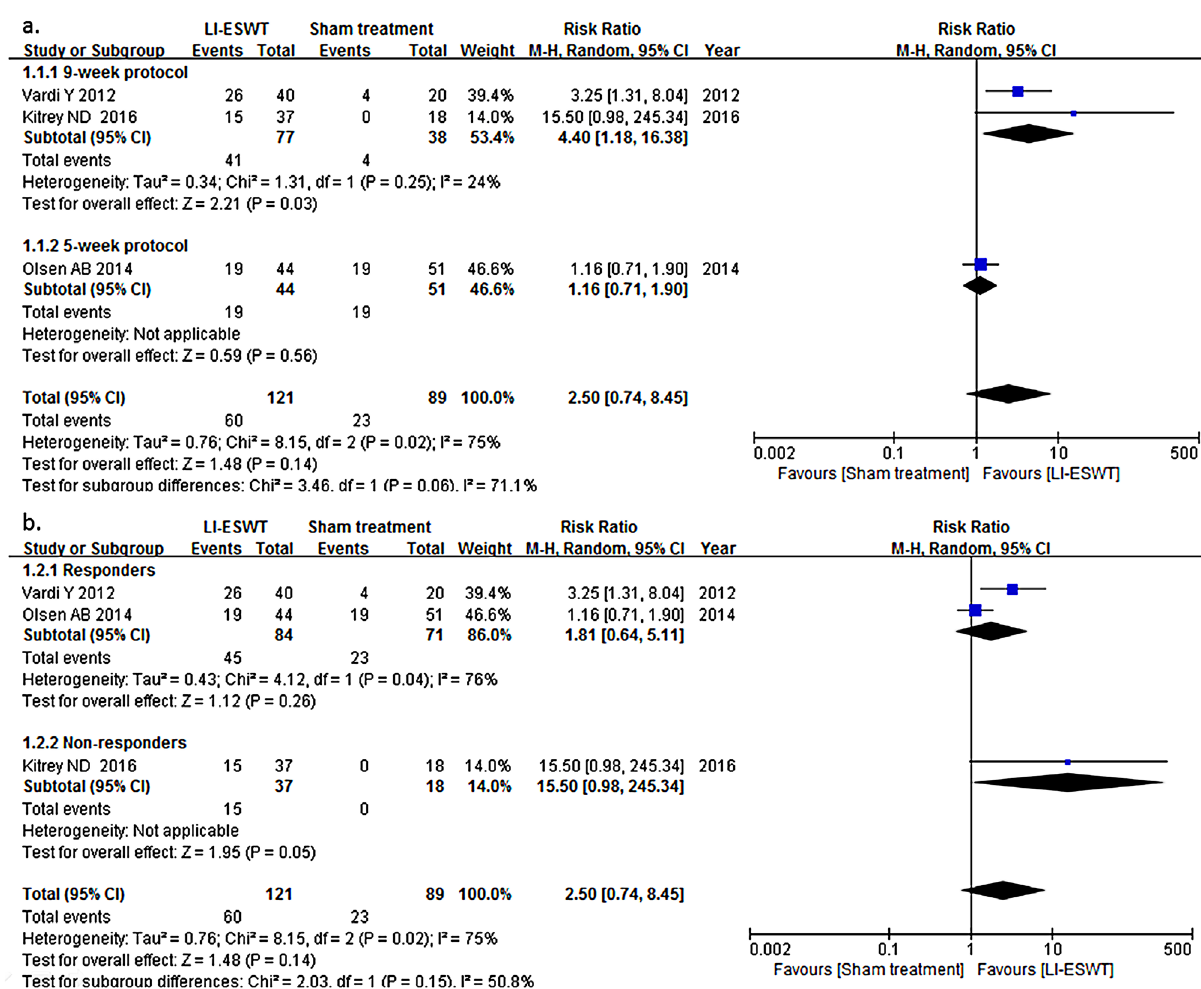
Figure 3 - Relationship of clinical variables and treatment procedures in International Index of Erectile Function-Erectile Function Domain (IIEF-EF). (a) The studies using the 9-week protocol of LI-ESWT more possibly contributed to effective treatment (risk ratio [RR]: 4.40; 95% confidence interval [CI]: 1.18-16.38; p=0.25), than using 5-week protocol (RR: 1.16; 95% CI: 0.71-1.90), although it did not reach statistical significance (p=0.06). (b) LI-ESWT for PDE5I non-responders more possibly contributed to effective treatment (RR: 15.50; 95% CI: 0.98-245.34), than for responders (RR: 1.81; 95% CI: